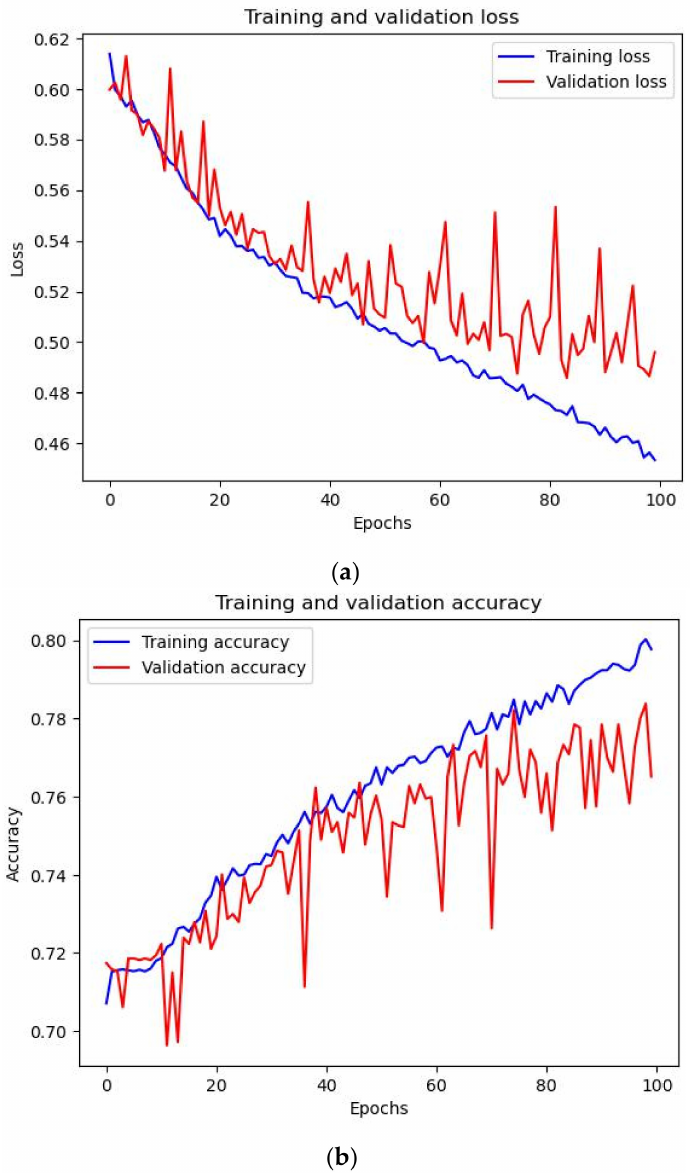
Figure 3. ( a ) Model Loss function values during training of model which detects pulmonary consoli- dation. ( b ) Accuracy plots during training of model which detects pulmonary